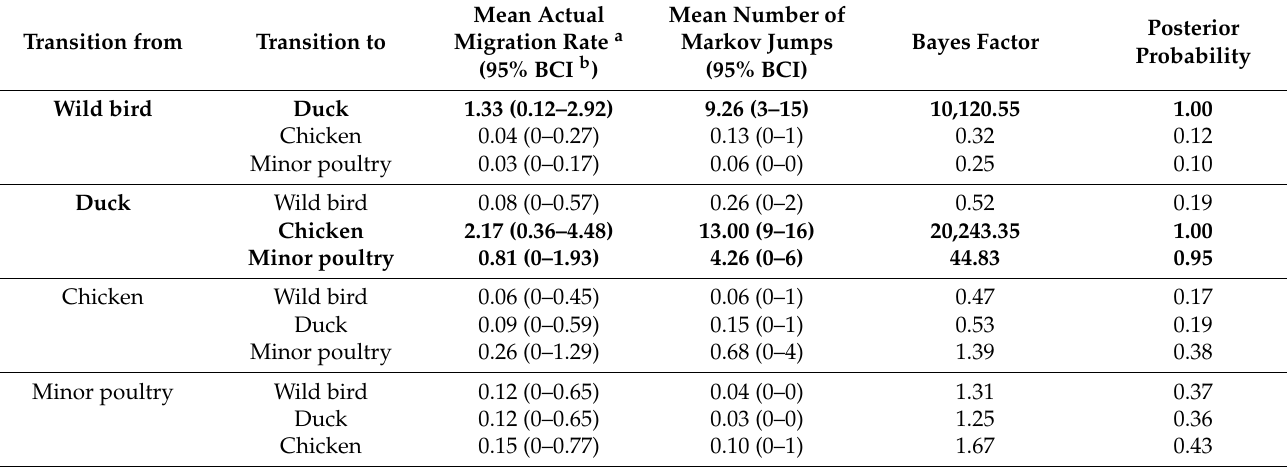
Table 1. Transition rates, numbers of Markov jumps, and statistical support values for host types for the HA gene of the H5N8 highly pathogenic avian influenza viruses isolated in South Korea during